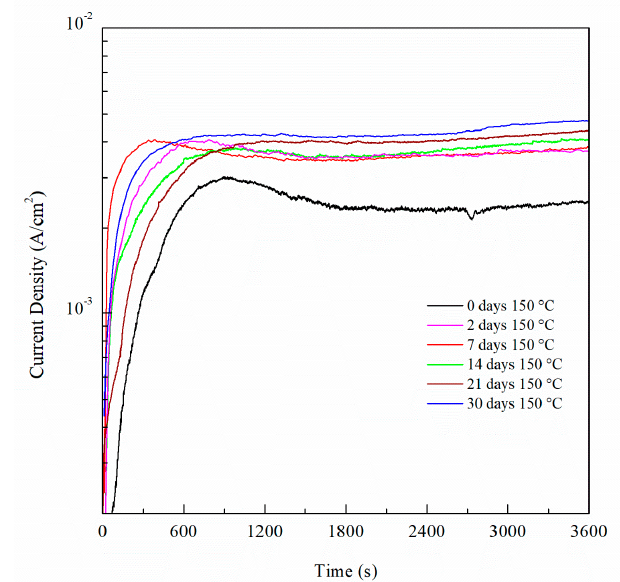
Figure 17. Potentiostatic current transient measured at − 0.71 V SCE of AA5083 sensitized at 150 °C for up to 30 days.